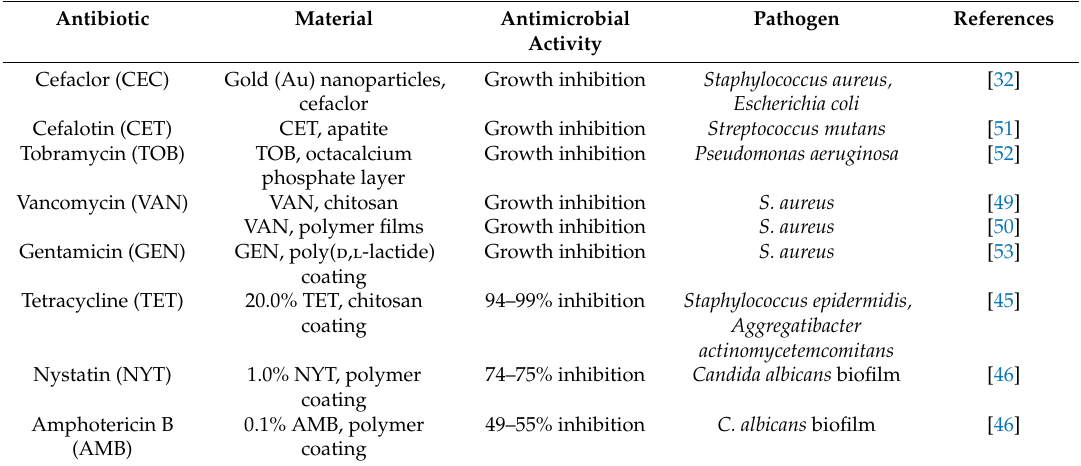
Table 3. Antibiotics used in bioactive coatings and their antimicrobial